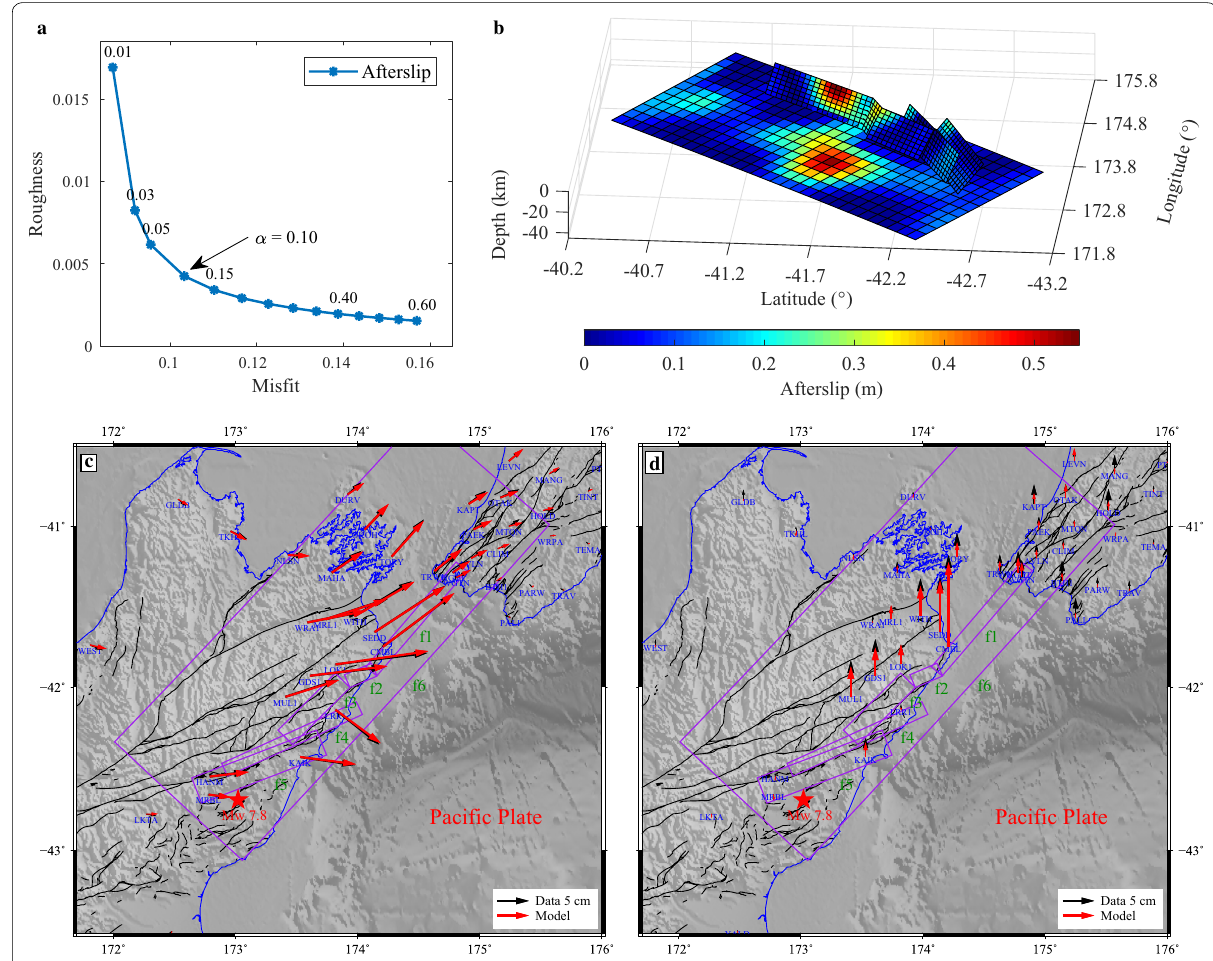
Fig. 6 Postseismic inversion results. a Trade-off curve (L-curve) between data misfit and model roughness in the postseismic model. b Spatial distri- bution of the postseismic afterslip. c and d Horizontal and vertical displacement fields with GPS observations (black arrows) and model predictions (red arrows), respectively. The six purple rectangles represent the surface projection of the faults in the postseismic